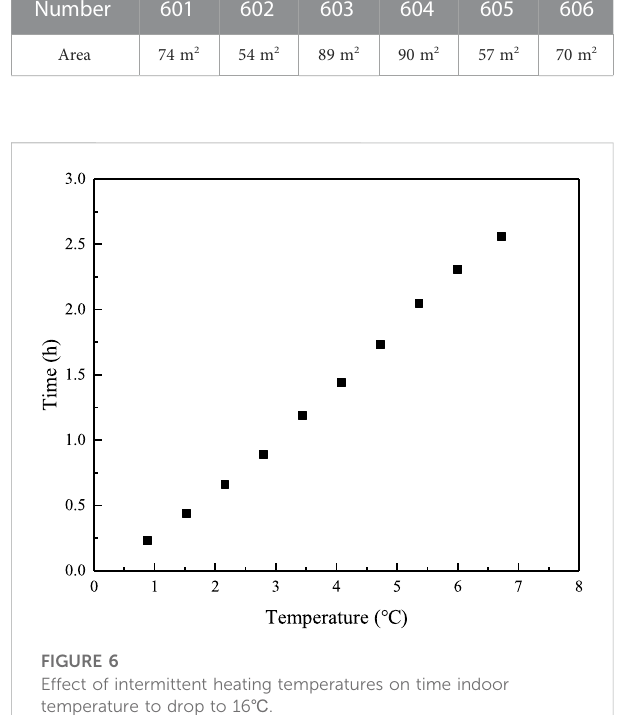
FIGURE 6 Effect of intermittent heating temperatures on time indoor temperature to drop to 16 ℃